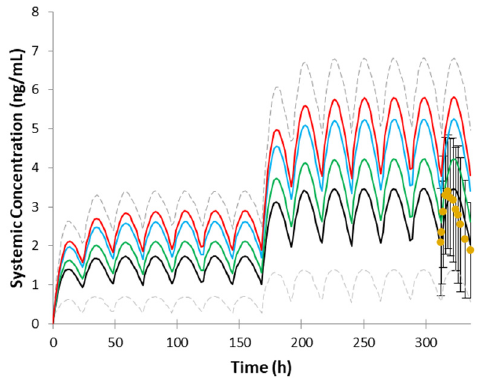
Figure 6. Mean observed (circles) and simulated (solid line) systemic plasma concentration–time profiles of ropinirole (5%th and 95%th percentiles are presented as grey dashed lines). Simulation of study No. ROP109087 (4 mg) using Sim-NEurCaucasian population, 47–81 years old (black line); Sim-Geriatric population 65–75 years old (green line); Sim-Geriatric population 75–85 years old (blue line); and Sim-Geriatric population 85–98 years old (red line). Dotted lines represent 5th and 95th percentiles, circles represent observed data. Data presented as mean and SD.